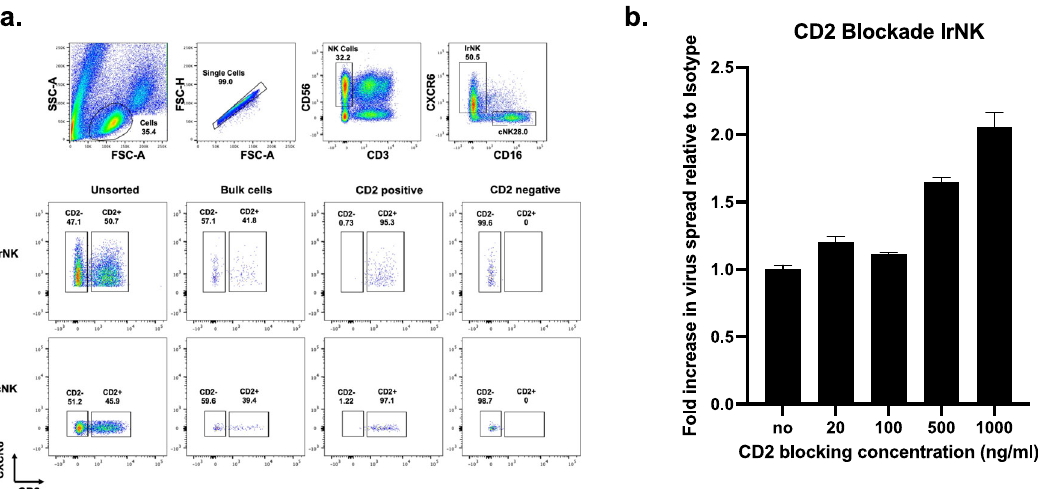
Fig.6|CD2blockadeinhibitscontrolofHCMVinfectionbyNKcells.a FACSsortedCD2+lrNKorcNKcellswereblocked( b )withaCD2antibodyorisotypecontroland then analysed for in vitro control of cell assoc. Merlin in a virus dissemination assay (replicates n =2). Source Data are provided as a Source Data fi